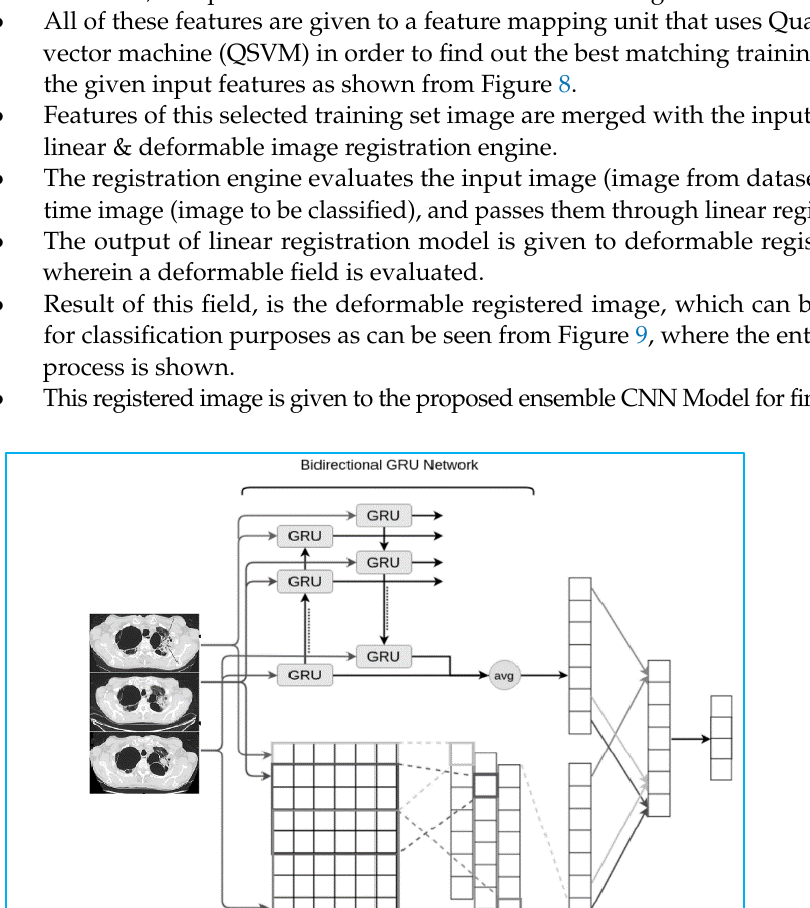
Figure 7. Bidirectional GRU with RNN for feature extraction.